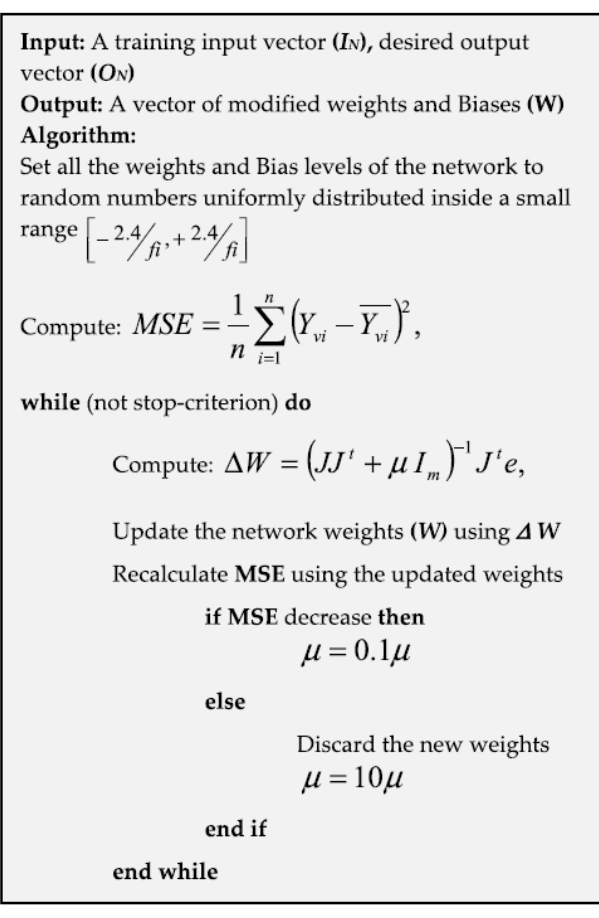
Figure 5. Levenberg Marquardt algorithm.